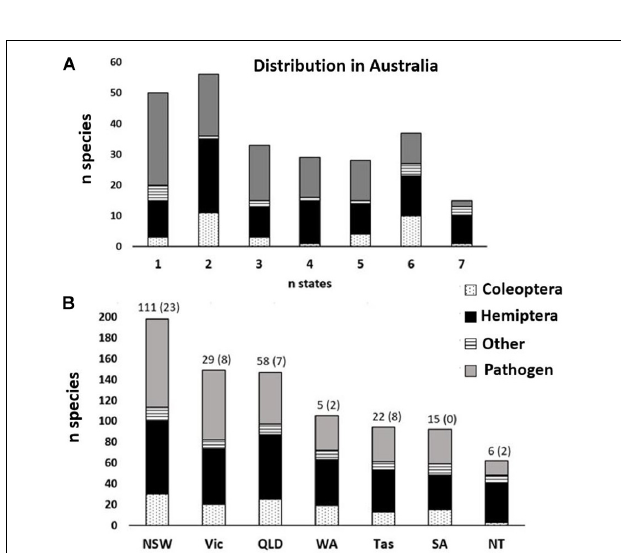
FIGURE 4 | State-wide adventive distribution of non-native forest arthropod (Coleoptera = stippled; Hemiptera = black; other = striped) and pathogen (gray) species ( n = 140) established in Australia by (A) number of states now present and (B) distribution within states. Numbers above the bars indicate the number of first detections in each state, with the number of species unique to that state (i.e., those that did not spread) in parentheses.